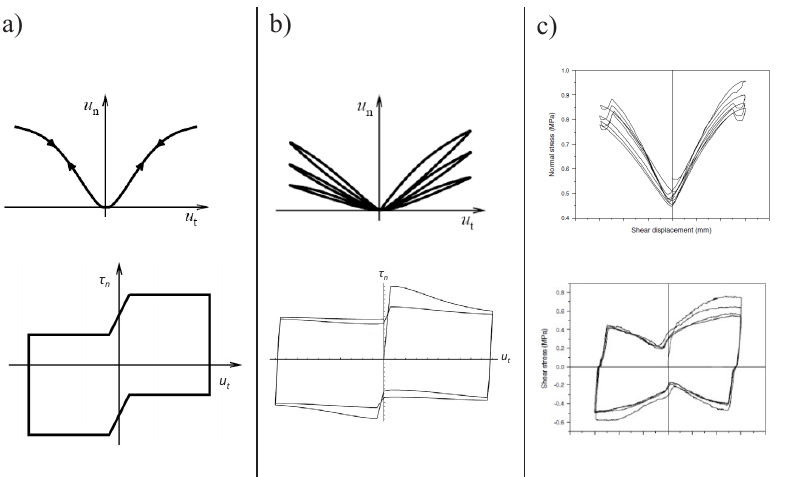
Fig 1 and fig. 3 – missing text Should be: Fig. 1: Fig. 3: